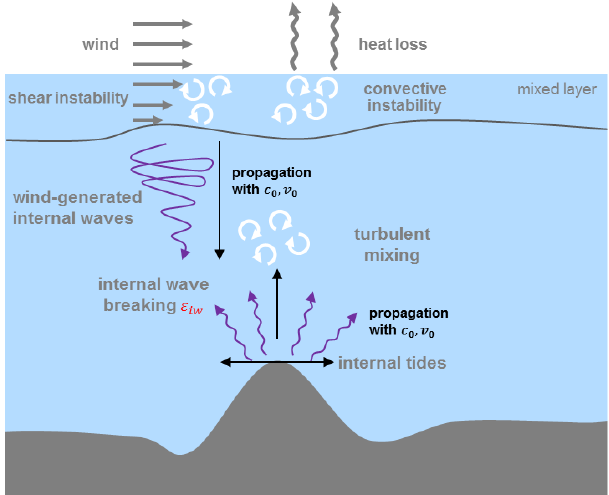
Figure A1. Schematic of the combined TKE + IDEMIX scheme used in HR ide . For processes parameterized in TKE, away from strong currents, shear and buoyancy instability (convection) are largest near the surface (grey arrows), causing strong mixing in the mixed layer (white eddy symbols). For processes parameterized by IDEMIX, below the mixed layer, internal waves are either induced by fluctuating wind stress or by interactions of barotropic tides with orographic features (violet arrows). The internal waves are propa- gating into the interior ocean (black arrows), where they eventually break and dissipate (white eddy